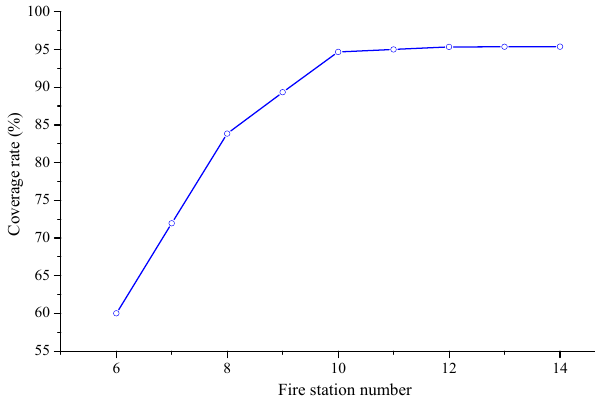
Figure 4. Coverage rates for different numbers of fire stations.